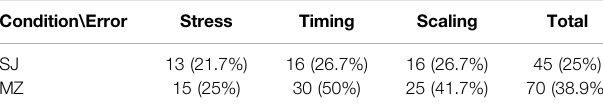
TABLE 2 | Stress, timing and scaling errors made by students in the Steve Jobs (SJ) and the Mark Zuckerberg (MZ) conditions.